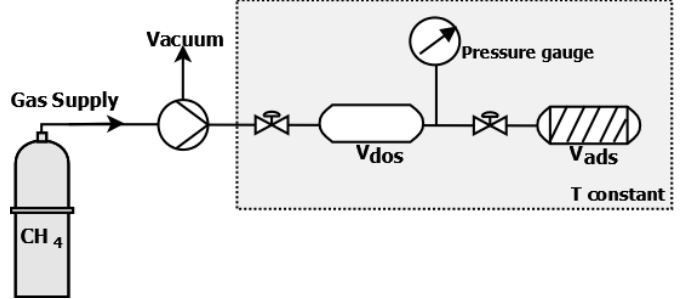
Figure 1. Schematic diagram of the high pressure and high temperature (HP/HT) manometric adsorption